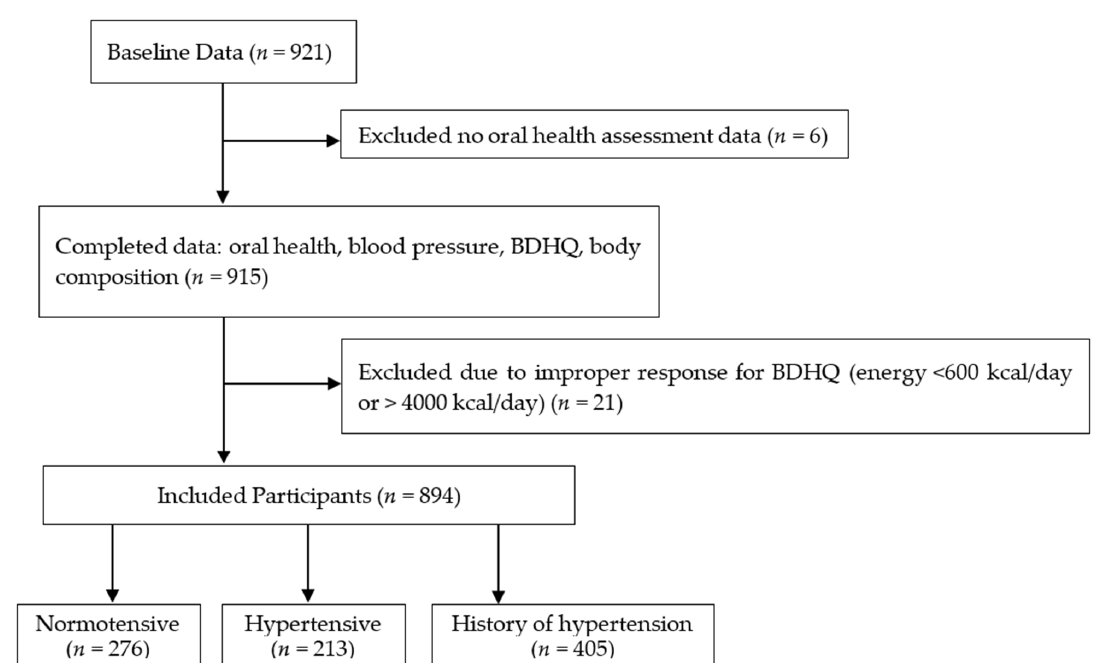
Figure 1. Flow diagram demonstrating the recruitment and group assignment of the study participants. BDHQ; a brief self-administered diet history questionnaire. Normotensive: Participants with systolic blood pressure (SBP) < 140 mmHg and diastolic blood pressure (DBP) < 90 mmHg, Hypertensive: Participants with SBP of ≥ 140 mmHg and/or DBP ≥ 90 mmHg, History of